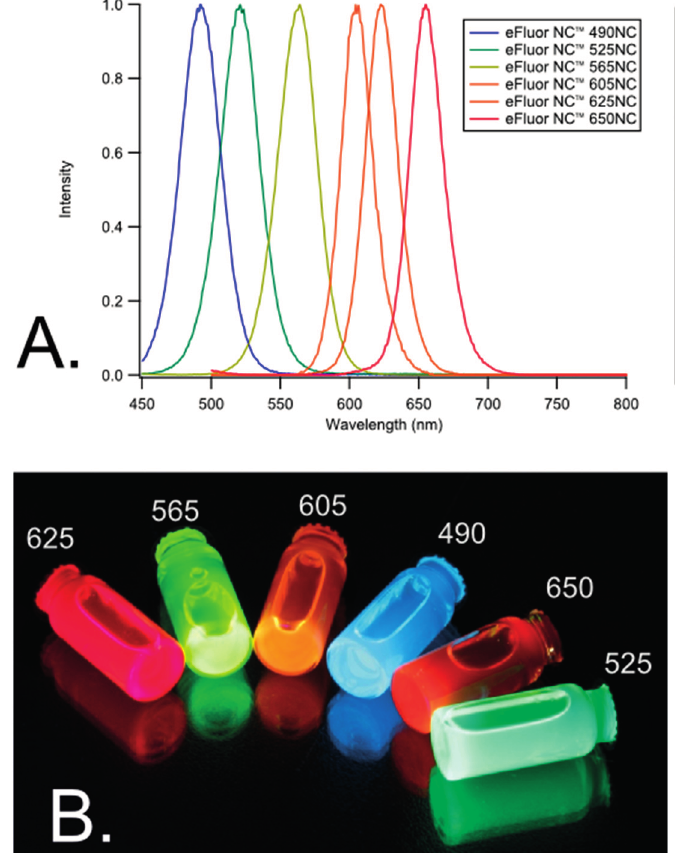
Figure 4. Properties of CdSe/ZnS quantum dots. ( A ) photoluminescence spectra; ( B ) quantum dots after UV excitation Adapted, with permission from [19]. Copyright (2011) American Chemical